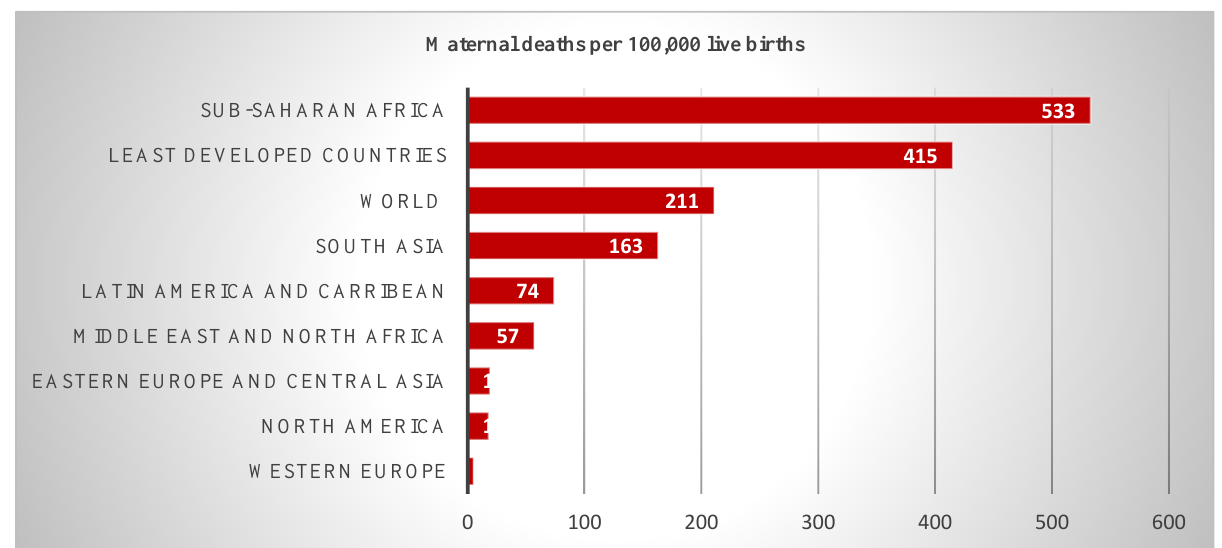
Figure 1. Maternal deaths per 100,000 live births (2017). Source: Graph computed using statistics from the World Bank (2022). World Bank. 2022. Indicators. Available online: https://data.worldbank.org/indicator (accessed on 25 April 2022).